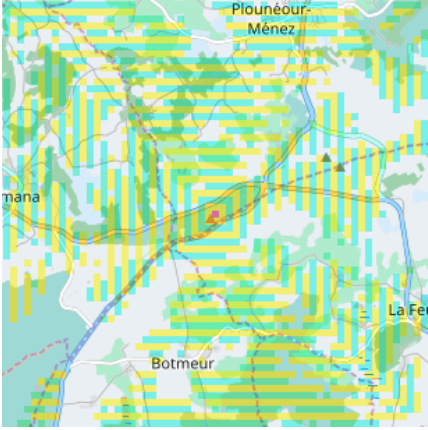
Figure 14. Radio signals propagate in concentric squares step by step. Reachable cells are represented in colored